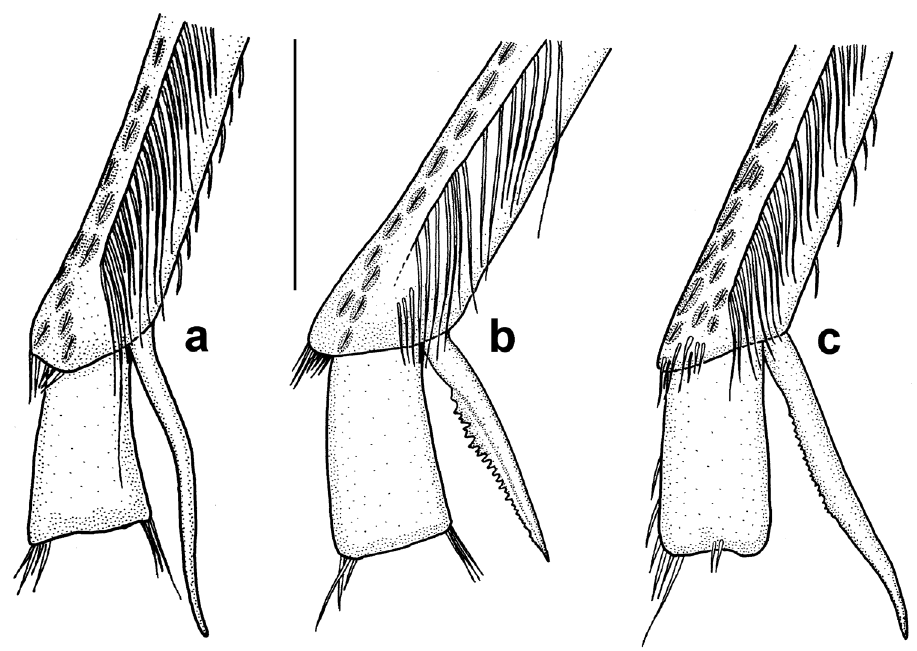
Figure 7. Hyphydrus male metatibia, longer metatibial spur and metatarsomere I. a H. anatolicus b H. ovatus c H. sanctus . Scale bar 0.5